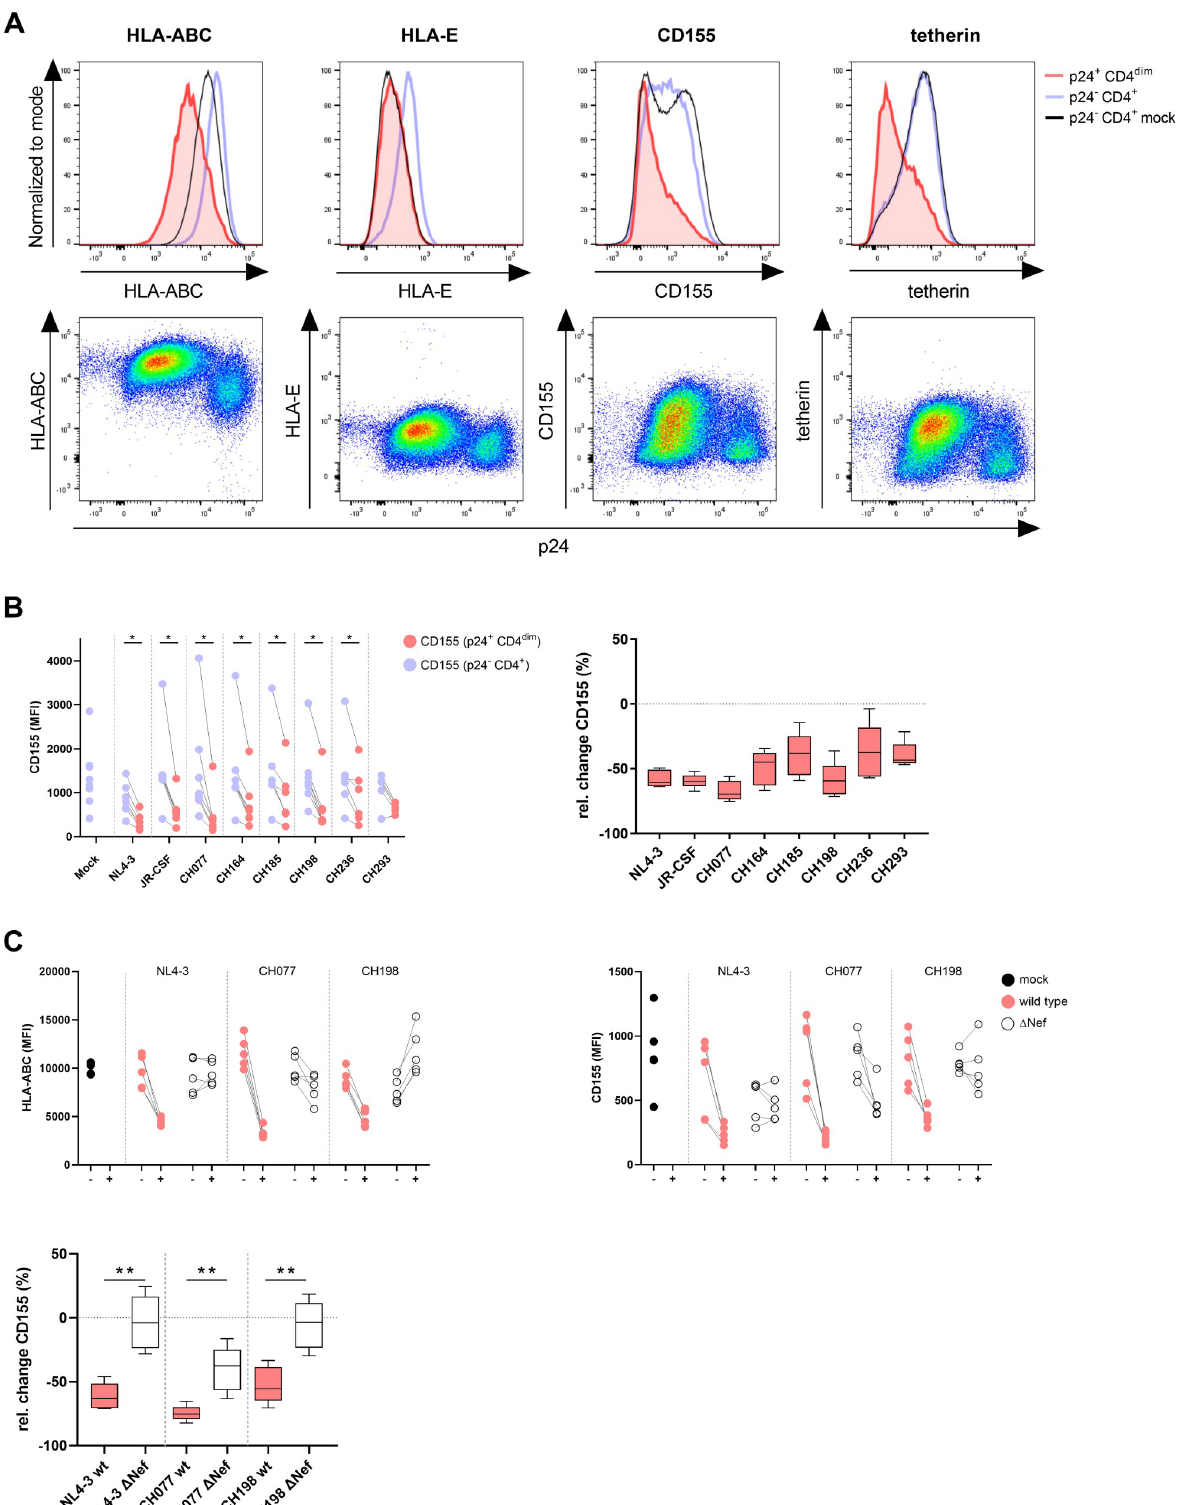
Fig 4. HIV-1 mediates downregulation of CD155 on infected CD4 + T cells in a Nef-dependent manner. (A) Expression levels of HLA-ABC, HLA-E, CD155 and tetherin were compared between HIV-1-infected (CH077) and uninfected CD4 + T cells. HIV-1-infected cells were determined by gating on p24 + CD4 dim cells and uninfected cells were defined as p24 - and CD4 + . Histograms show surface expression of the indicated molecules